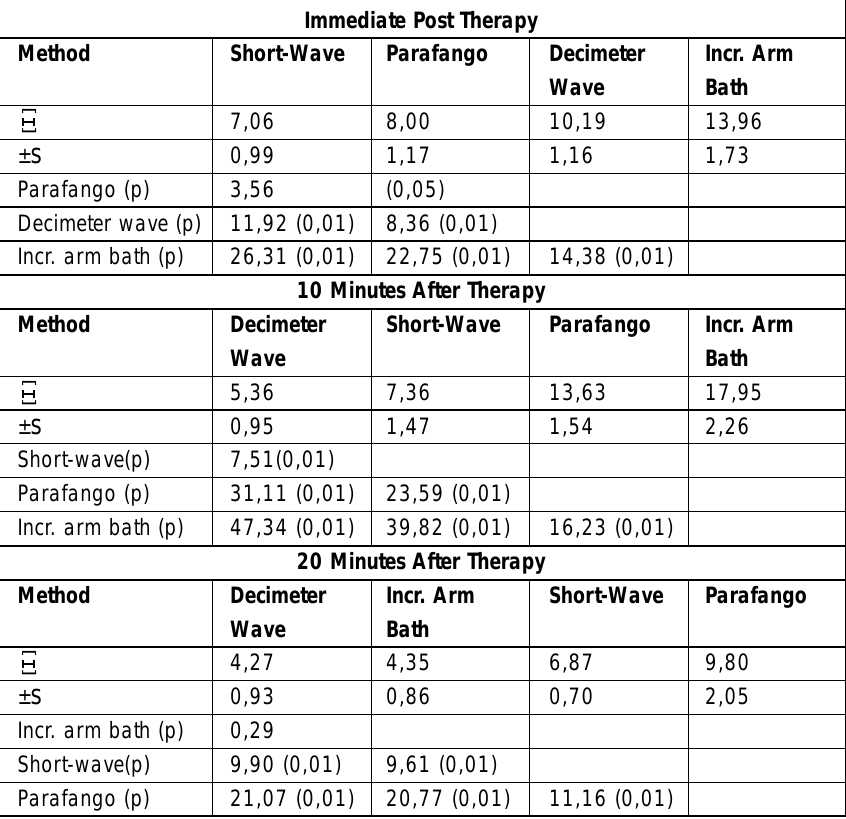
Table 1: Mean value comparisons (Newman-Keuls-test) of the post therapeutic reaction of circulation on the application side within the patients’ collectives.